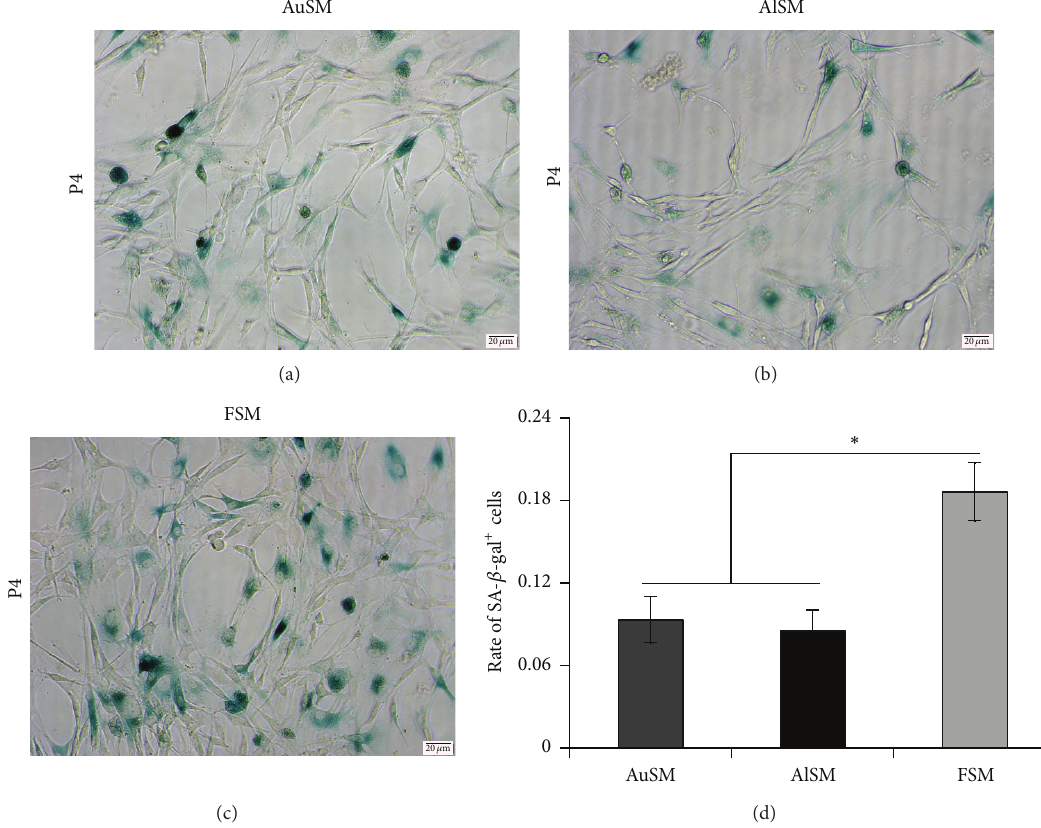
Figure 3: Senescence analyses of BMSCs cultured in AuSM, AlSM, and FSM. (a–c) SA- 𝛽 -gal staining of BMSCs cultured in (a) AuSM, (b) AlSM, and (c) FSM. (d) Mean percentage of senescent cells in BMSCs from AuSM, AlSM, and FSM ( 𝑛 = 3 ). Scale bars = 20 𝜇